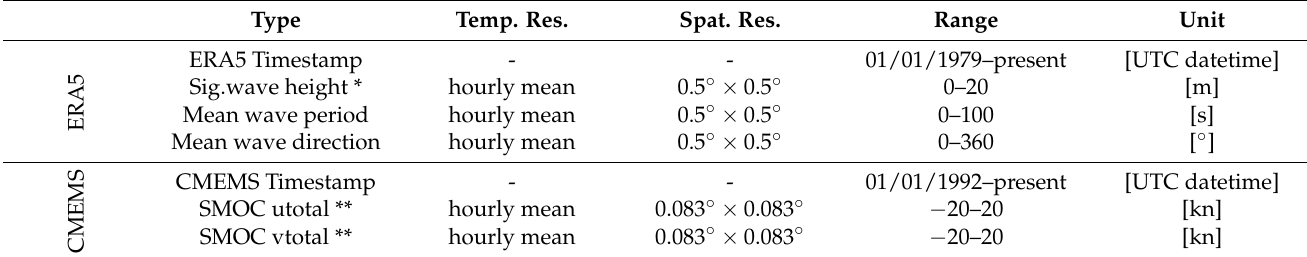
Table 7. Temporal and spatial resolution, acquisition range and units of weather data. * Sig.wave height refers to the significant height of combined wind waves and swell. ** SMOC refers to Surface and Merged Ocean Currents. Temp.